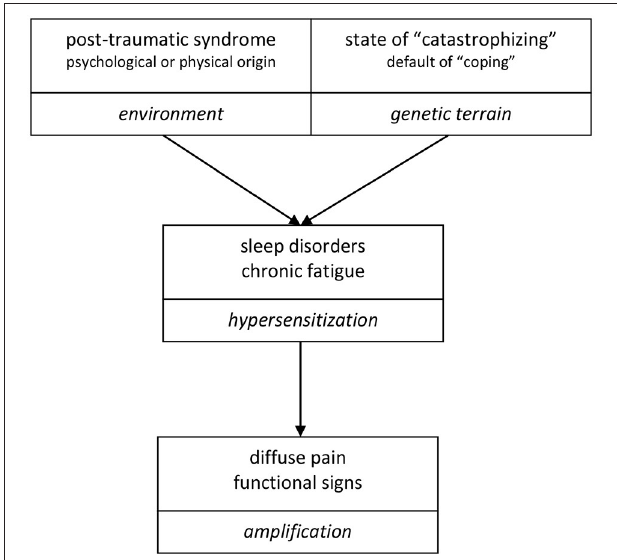
FIGURE 1 | Respective role played over time of the psyche, sleep disorders, fatigue, pain, and sensory functional disorders: kinetic analysis of the events occurring in the life of a fibromyalgia patient. The traumatic psychological events are old, or even dating back to childhood. The sleep disorders are secondary and quickly associated with a state of fatigue, which precede often by several years the chronic pain state and associated functional signs, in the sequence illustrated